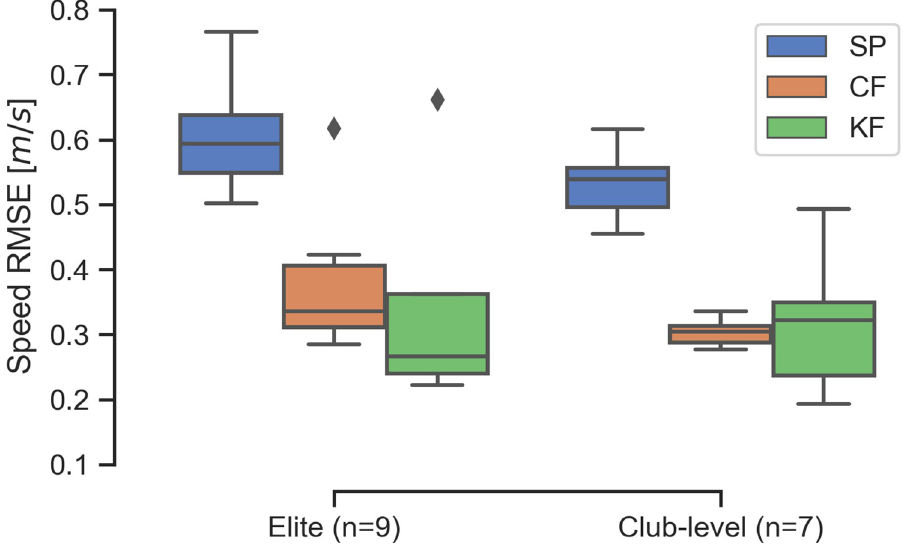
Fig 15. Summary of the speed estimate error for all trials. Comparisons of the distributions of RMSE v of the speed estimates from the three methods for the last 10 strokes of each trial.